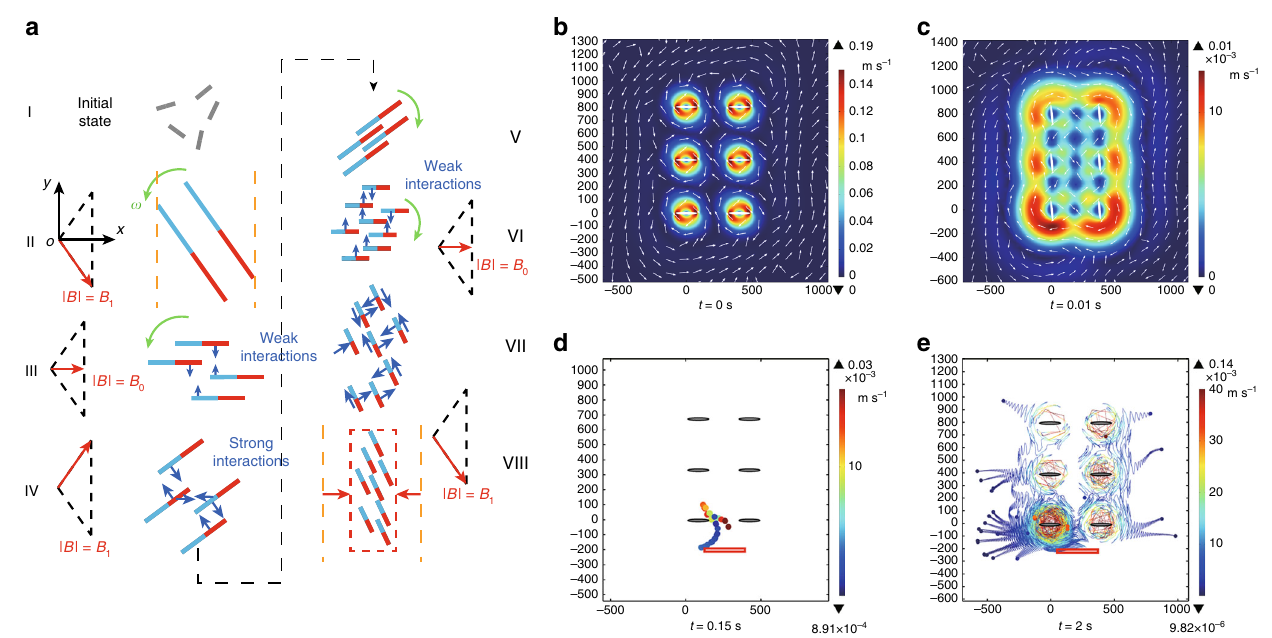
Fig. 2 Schematic explanation of the swarm generation and simulation results of hydrodynamic signature. a The schematic generation process of an RPNS (Supplementary Movie 2). The rods illustrate nanoparticle chains, and the blue and red parts show the different magnetisations. b , c The simulation results of the fl ow fi eld induced by an array of oscillating spheroids at t = 0 s and t = 0.01 s. The input amplitude ratio is 3, and the oscillating frequency is 20 Hz. d The simulation results of the motion of 30 free particles with a diameter of 10 μ m at the tip of the array, at t = 0.15 s. The particles are released at t = 0 s, and are released from the red rectangle. e The trajectories of the particles at t = 2